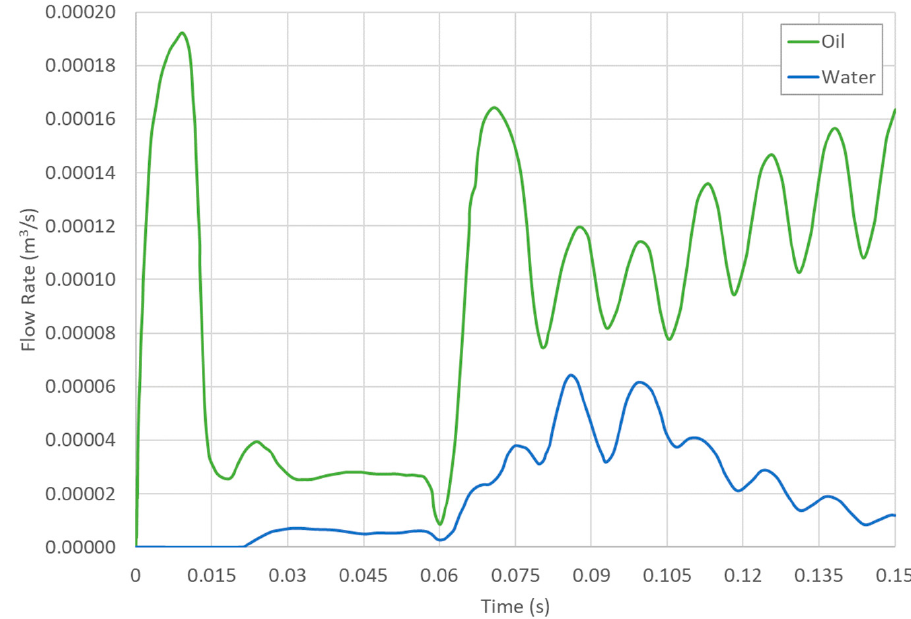
Figure 16. Production rate profile of the oil and the water vs. process time. The oil’s profile increased immediately above the expected 0.000184 m 3 /s or 100 bar- rels per day, decreased due to water entry, and had a small oscillation similar to the plate’s translation. As this stabilized quickly, production increased in an oscillatory manner with the oil entry. This was well matched to the plate’s behavior at this stage. On the other hand, water production was almost zero until 0.0216 s, when it remained stable but below 9.2 × 10 − 6 m 3 /s (5 barrels per day). With the oil entry, the production oscillated until it reached 7 × 10 × 10 − 6 m 3 /s (38 barrels per day); it decreased with the same behavior. 3.2. Mesh Independency Two different sets of simulations were analyzed. In the first case, steady-state simu- lations were performed. The simulations were performed in an unsteady state in the sec- ond case while considering the DFBI and mesh morphing models. For both cases, there three different meshes were considered (N i ). In each case, the pressure drop and mass flow were analyzed. The analyses of the cases were carried out to determine how the meshing independence results with the mesh morphing and DFBI model and with a dif- ferent temporal discretization could change. The results of the GCI analysis are shown in Table 4. Table 4. Results of mesh independence with the GCI parameters were calculated for the two differ- ent cases with the three defined meshes. 𝑁 (cid:2869) , 𝑁 (cid:2870) , and 𝑁 (cid:2871) are the element counts from the most re- fined mesh ( 𝑁 (cid:2869) ) to the coarser mesh ( 𝑁 (cid:2871) ). Parameter